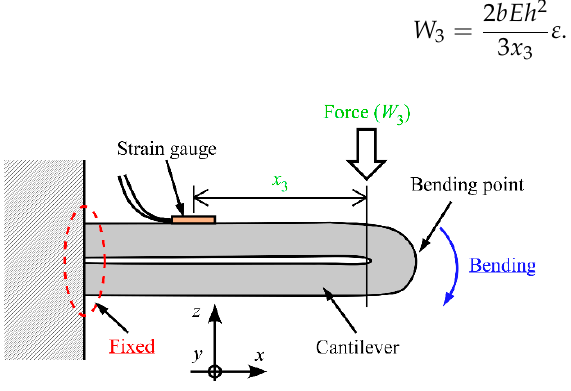
Figure 2. Bending state of beam. The cantilever is folded twice around the y -axis and the tip is fixed to the root of the beam.